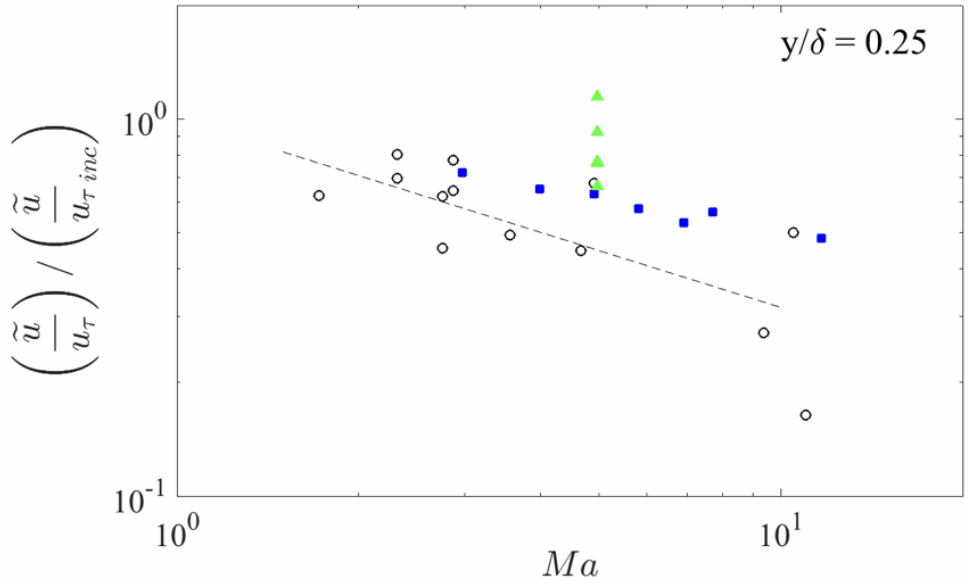
Figure 3. The effect of Mach number on streamwise velocity fluctuations. Symbols as in Figure 2.